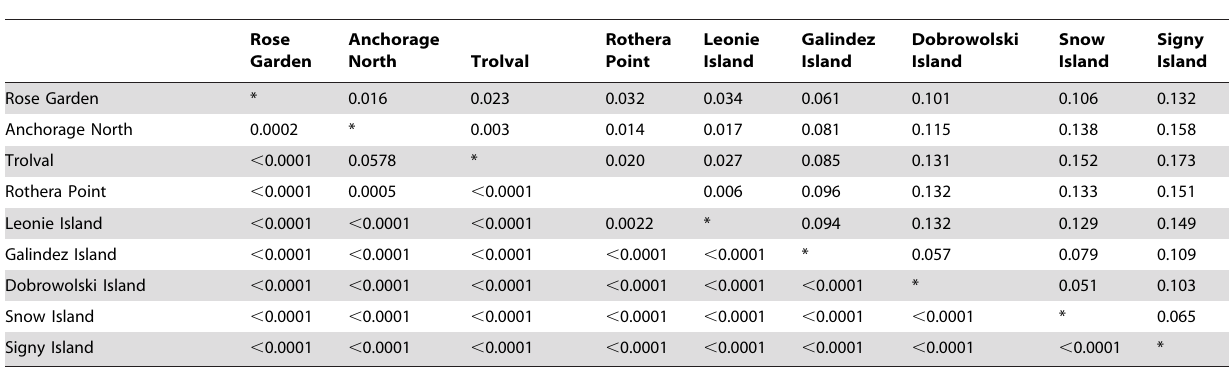
Table 4. Pairwise F st values among M. antarctica sampled from nine different sites (above